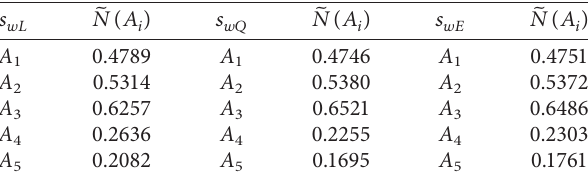
Table 4: Relative closeness coefficients.